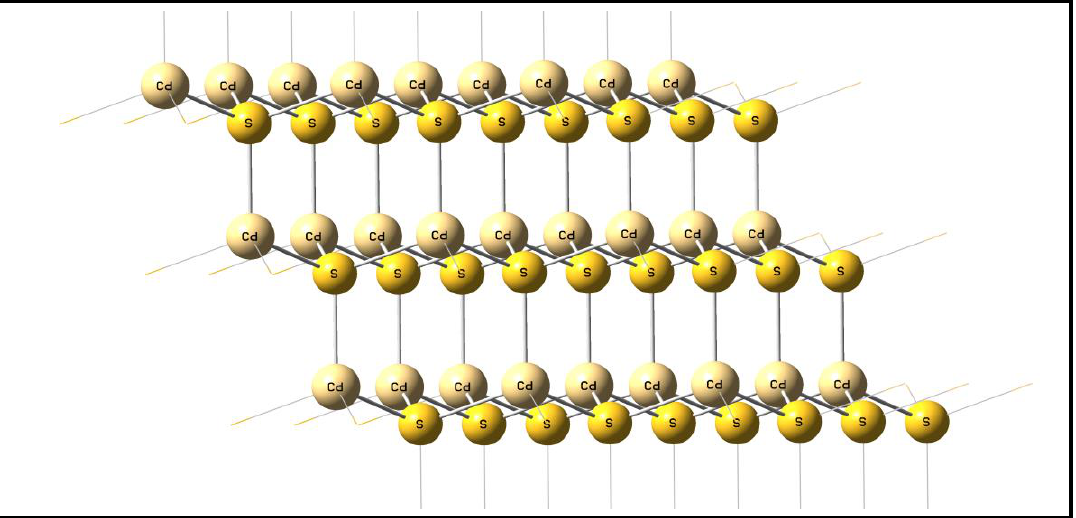
Fig. 1: (color online) CdS 54 atoms core LUC (parallelepiped shape primitive cell multiplet).